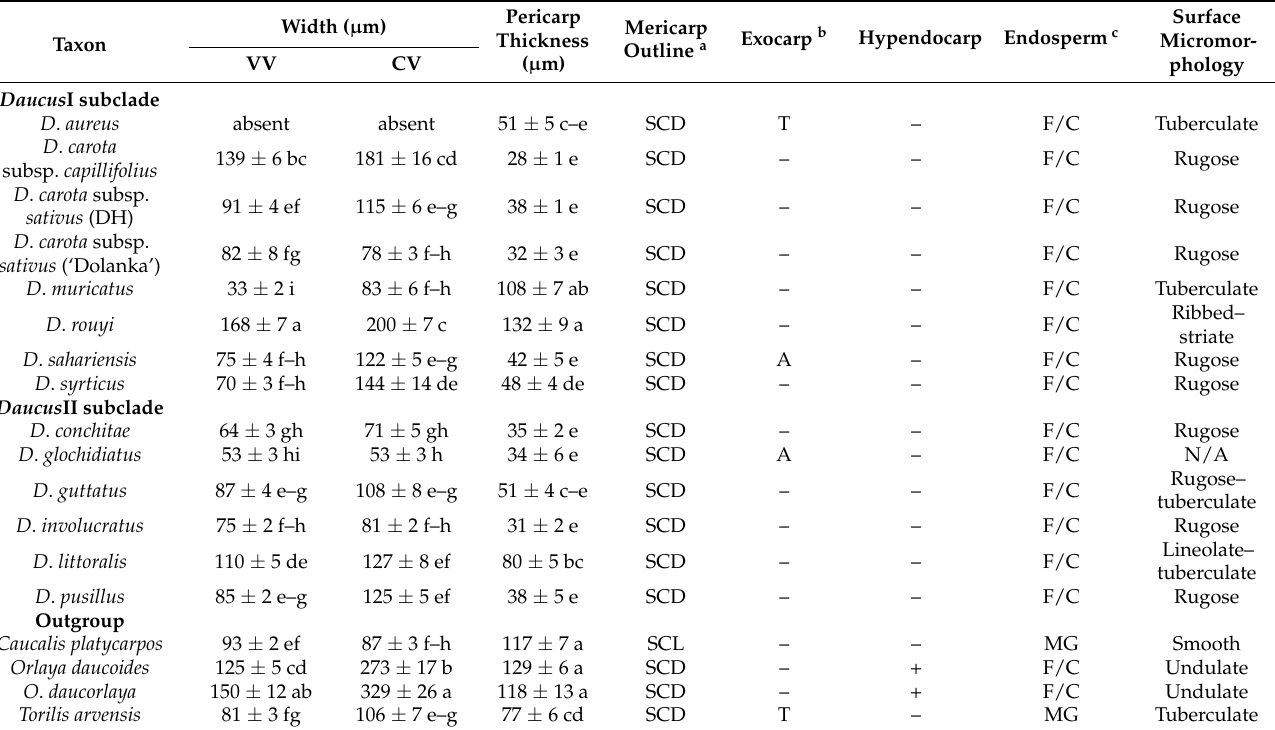
Table 2. Fruit (mericarp) anatomical characteristics of the investigated Daucus and closely related non- Daucus (outgroup)